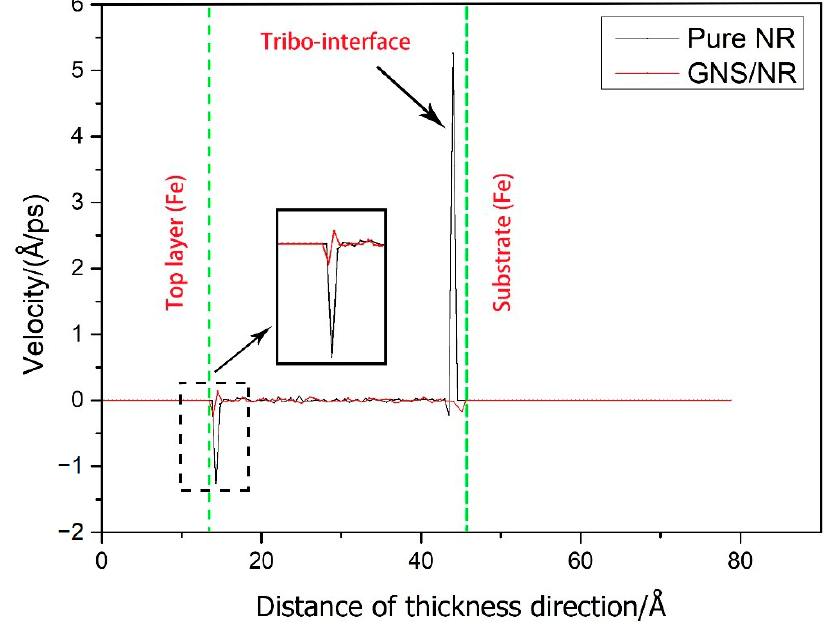
Figure 8. Velocity distribution of pure NR and GNS/NR composites in the thickness direction.